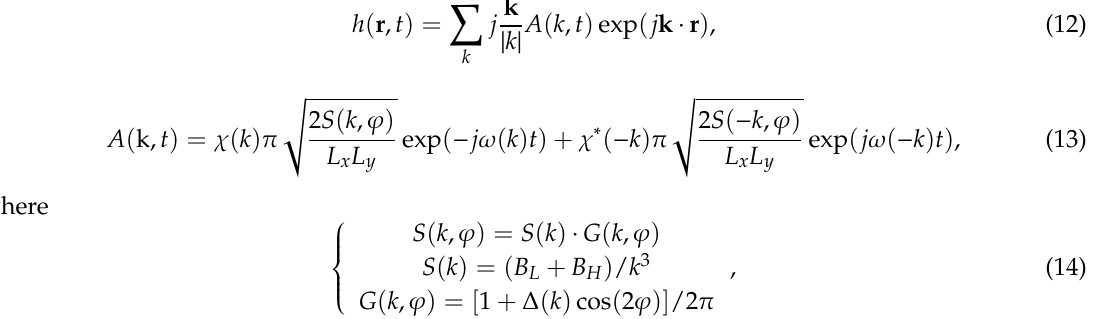
Figure 3. The sea spectrum for various wind speeds.